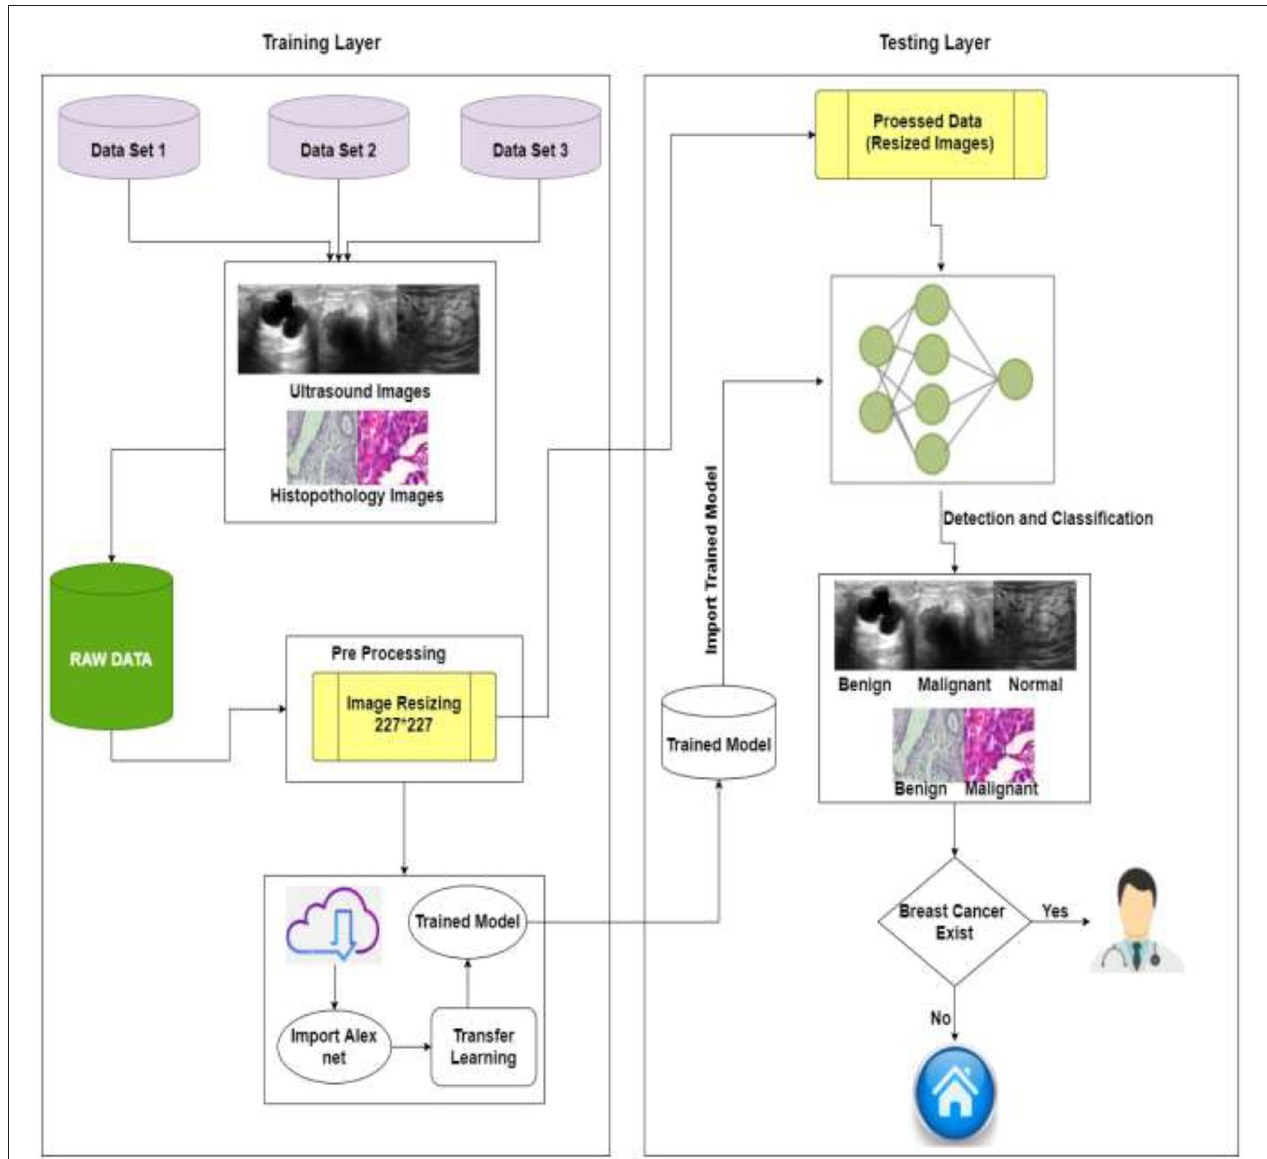
FIGURE 4 | Proposed system model of BC identification and